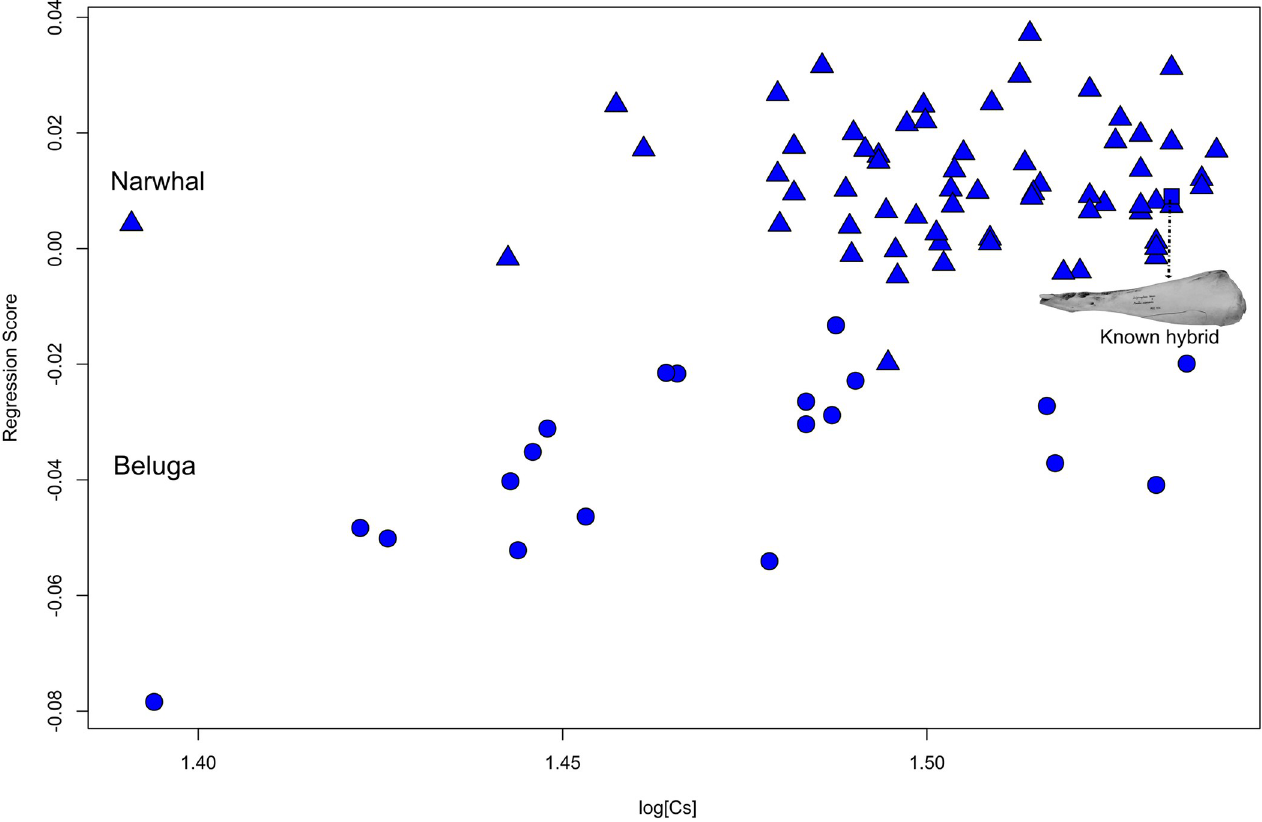
Fig 6. Allometry in mandible dataset. Regression of hemi-mandibular shape component against log CS for both narwhals (triangles) and belugas (circles) shows mandibular shape changes in relation to size. Dotted line shows the known hybrid hemi-mandible.